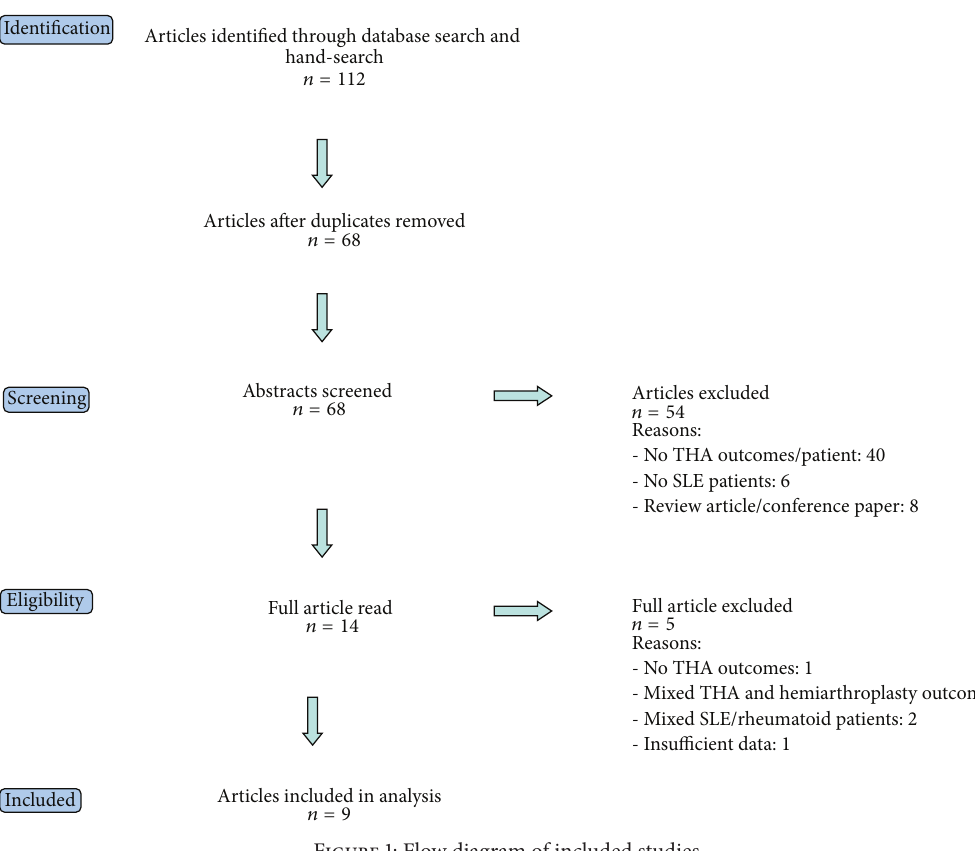
Figure 1: Flow diagram of included